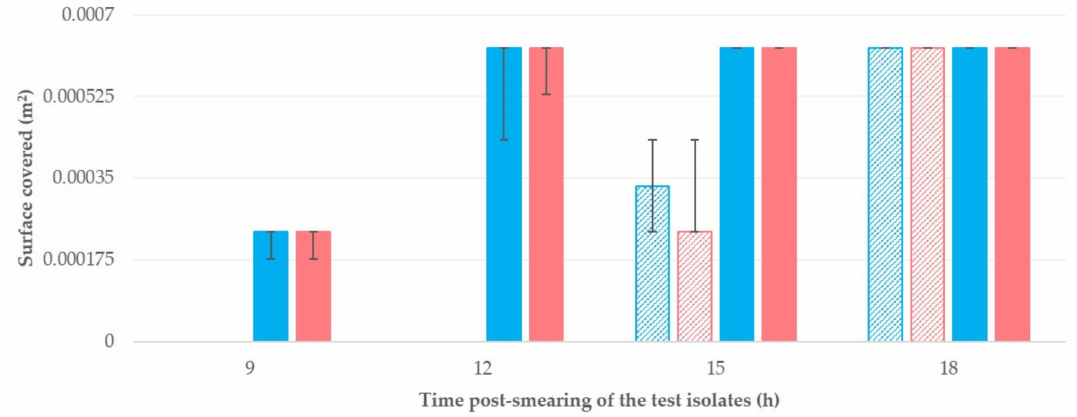
Figure 4. Median (min–max) surface covered (m 2 ) by two isolates of S. epidermidis (isolate A: blue colour; isolate B: red colour; p > 0.35 for all comparisons) at different time-points after smearing on teatcups from milking parlours for cattle (massif pattern) or sheep (full pattern) ( p < 0.01 for comparisons at 9 h, 12 h and 15 h